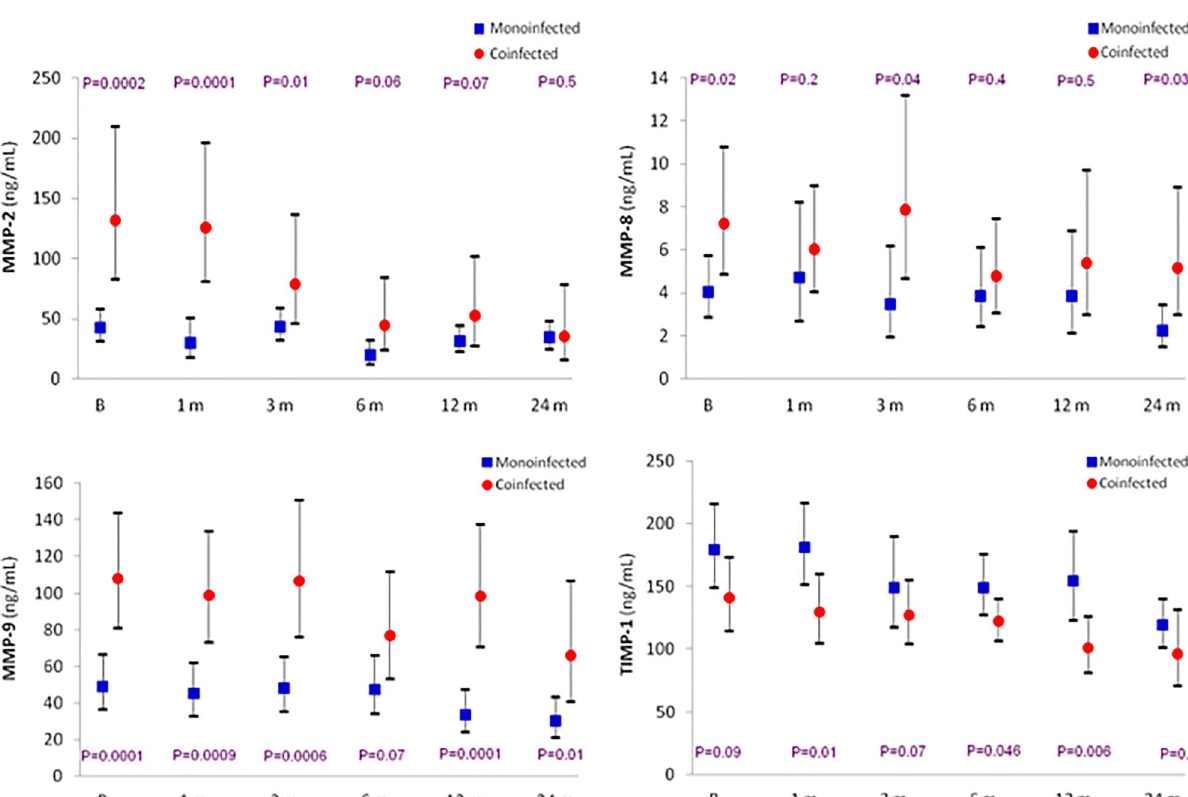
Figure 6. Course over time of MMP-2, MMP-8, MMP-9 and TIMP-1 in mono- and coinfected patients (mean, 95%